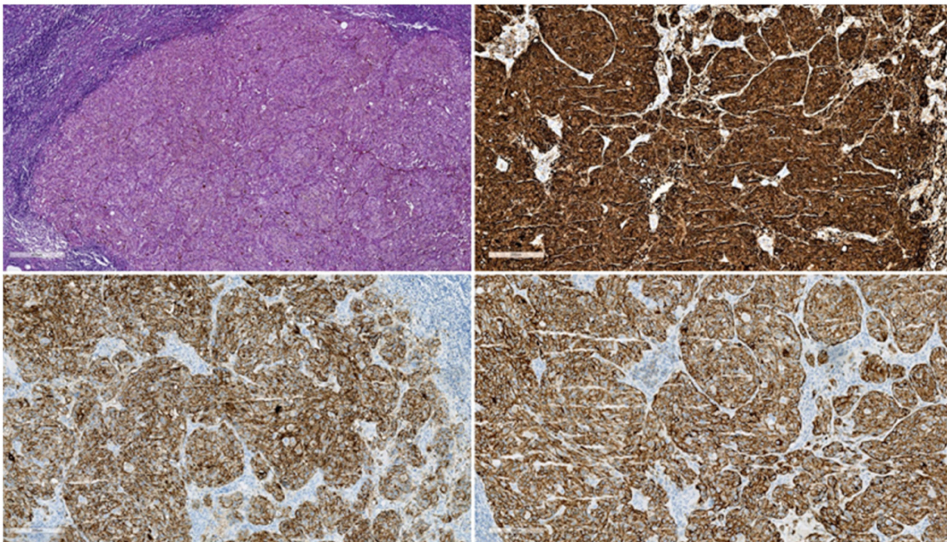
Figure 2. Secondary metastases of cutaneous melanoma in a mesenteric lymph node: Left up panel: Solid mass of tumor cells without pigment deposition, HE, 50 × Right up panel: diffuse strong positive reaction to S-100 in tumor cells, left down panel: diffuse positive reaction to HMB-45, IHC, 100 × , right down panel: diffuse positive reaction to MART-1 in tumor cells, IHC, 100 × . The existence or absence of nodal metastases in melanoma has long been acknowledged as a crucial aspect of patient care. However, there has been a lot of discussion over the specifics of that relevance. Researchers and clinicians [5] have split into two groups: those who think lymph nodes are an incubator for sequential progression and metastasis, and others who think lymph nodes are just a marker of any melanoma’s potential for spread. In terms of managing localized nodes when there are no clinically obvious symptoms at the time of diagnosis, the disagreement has had a considerable practical impact on